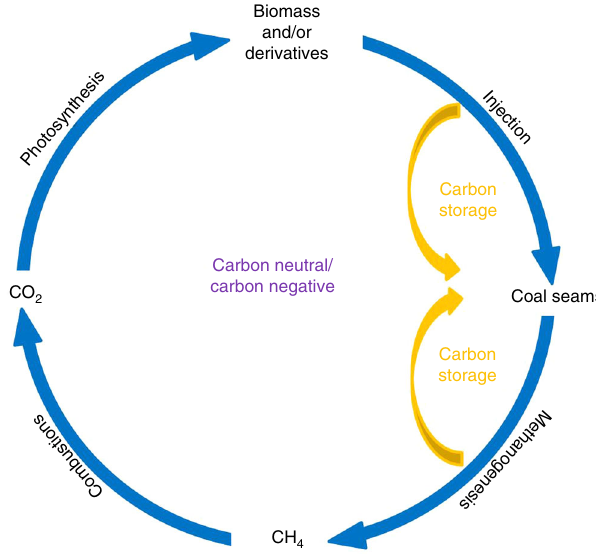
Fig. 1 Schematic depicting the concept of low carbon renewable natural gas produced using coalbeds as geobioreactors and as sinks for carbon capture and storage. The concenpt is intended to take advantage of the coal seams as natural geobioreactors that use biomass derived simple sugars as the carbon source for natural gas production. Coal seams also serve as a sink for sequestering microbial biomass and carbon dioxide, further lowering the carbon intensity of the